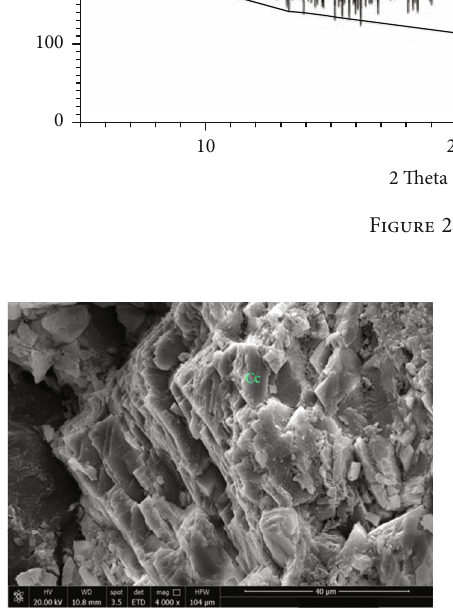
Figure 3: SEM result of A1core